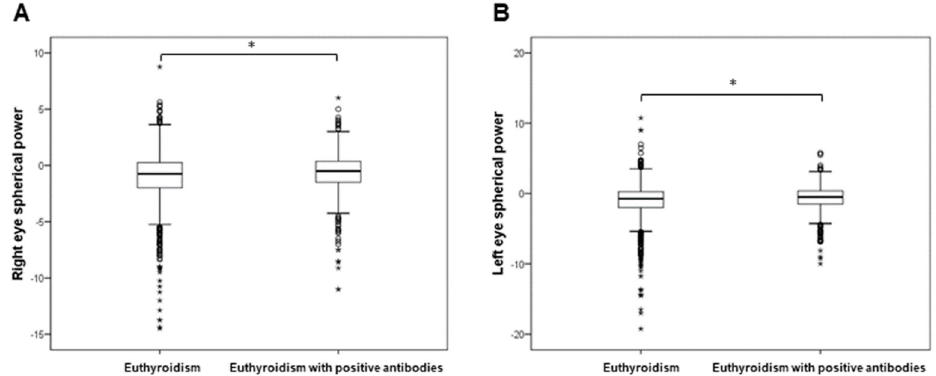
Figure 3. Comparison of ocular parameters between euthyroid individuals with positive antibodies and euthyroid individuals. ( A ) Right eye spherical power, ( B ) left eye spherical power. * p < 0.05.